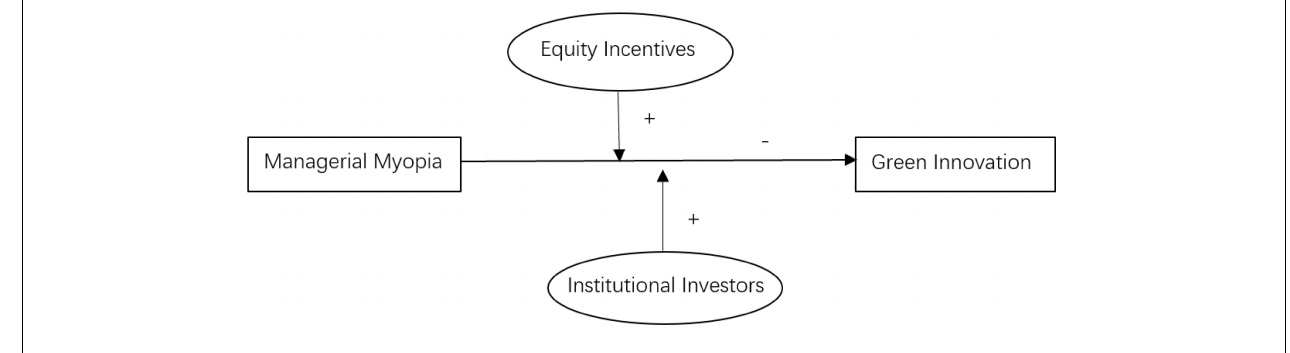
FIGURE 1 | Theoretical model. TABLE 1 | Variable